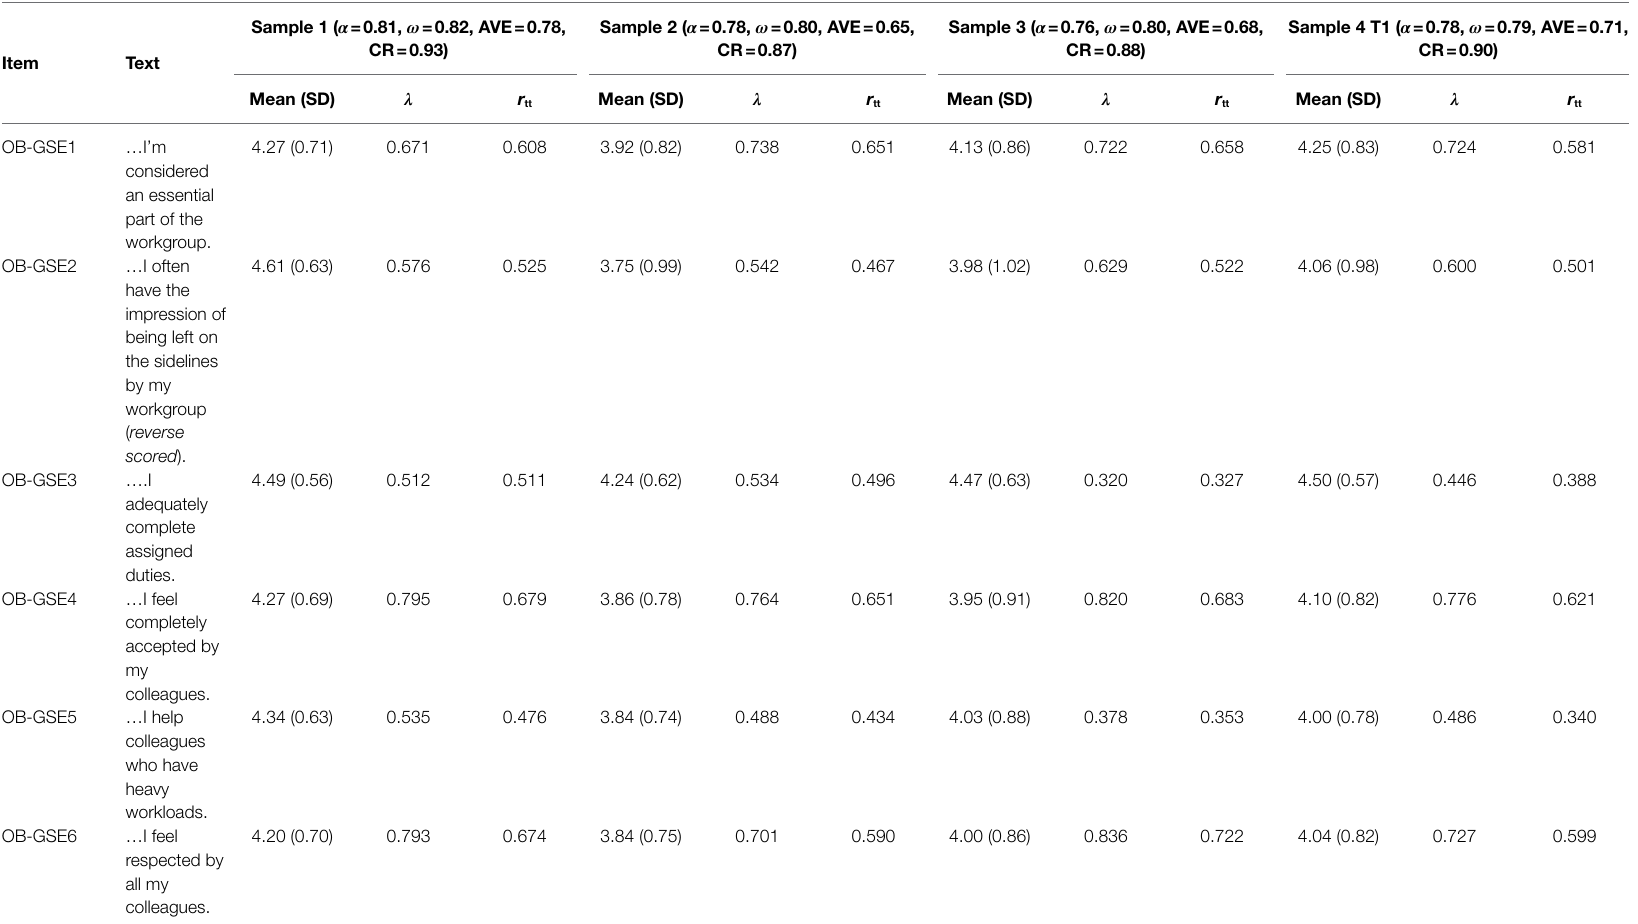
TABLE 2 | Descriptive statistics, factor loadings and item-total scale-score-corrected correlation for each item the OB-GSE in all study samples.